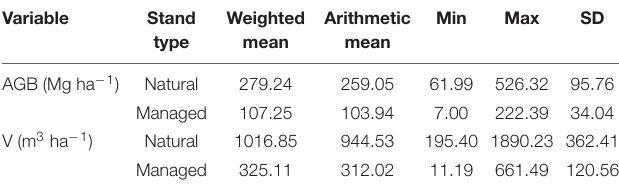
TABLE 1 | Summary of stand-level estimates based on VRP